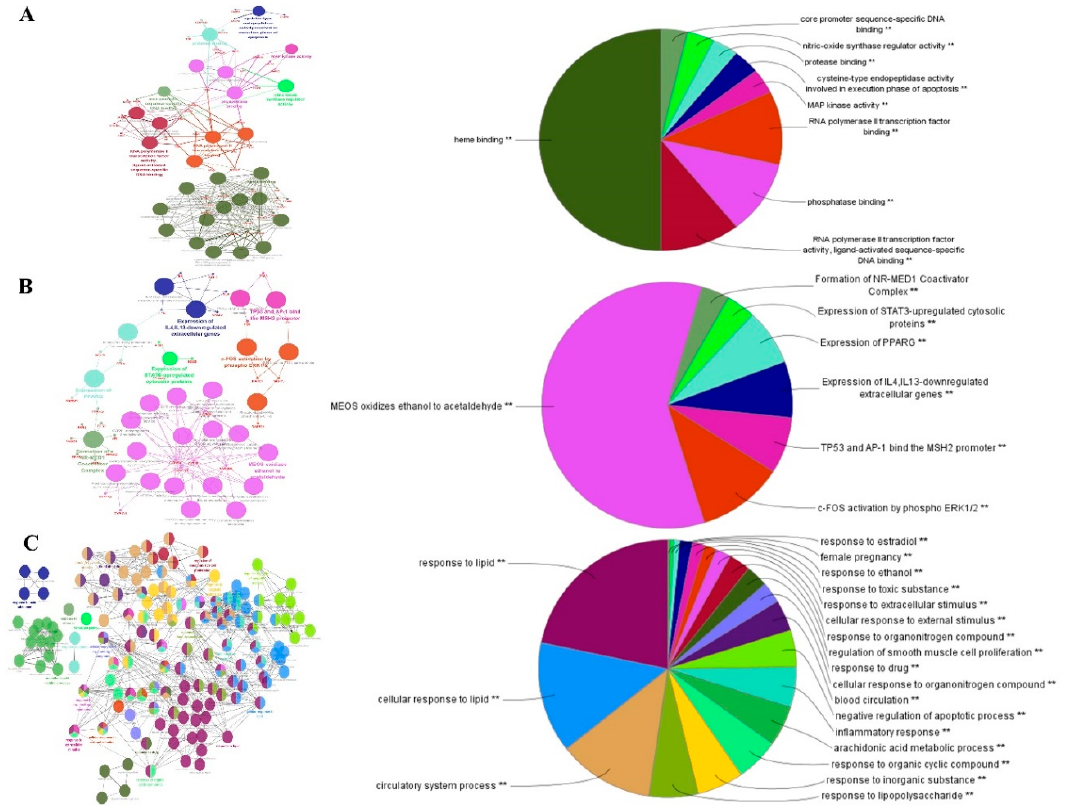
Figure 2. ClueGO analysis of the pungent flavored compound targets. A functionally grouped network of enriched categories was generated for the target genes. Gene ontology (GO) terms are represented as nodes, and the node size represents the term enrichment significance. Functionally related groups partially overlap. The node pie charts represent the molecular function, immune system processes, reactome analysis of targets. Only the most significant term in the group was labeled. ( A ) Representative molecular function interactions among targets. ( B ) Representative reactome analysis interactions among pungent flavored compounds’ targets. ( C ) Representative biological process among pungent flavored compounds’ targets.